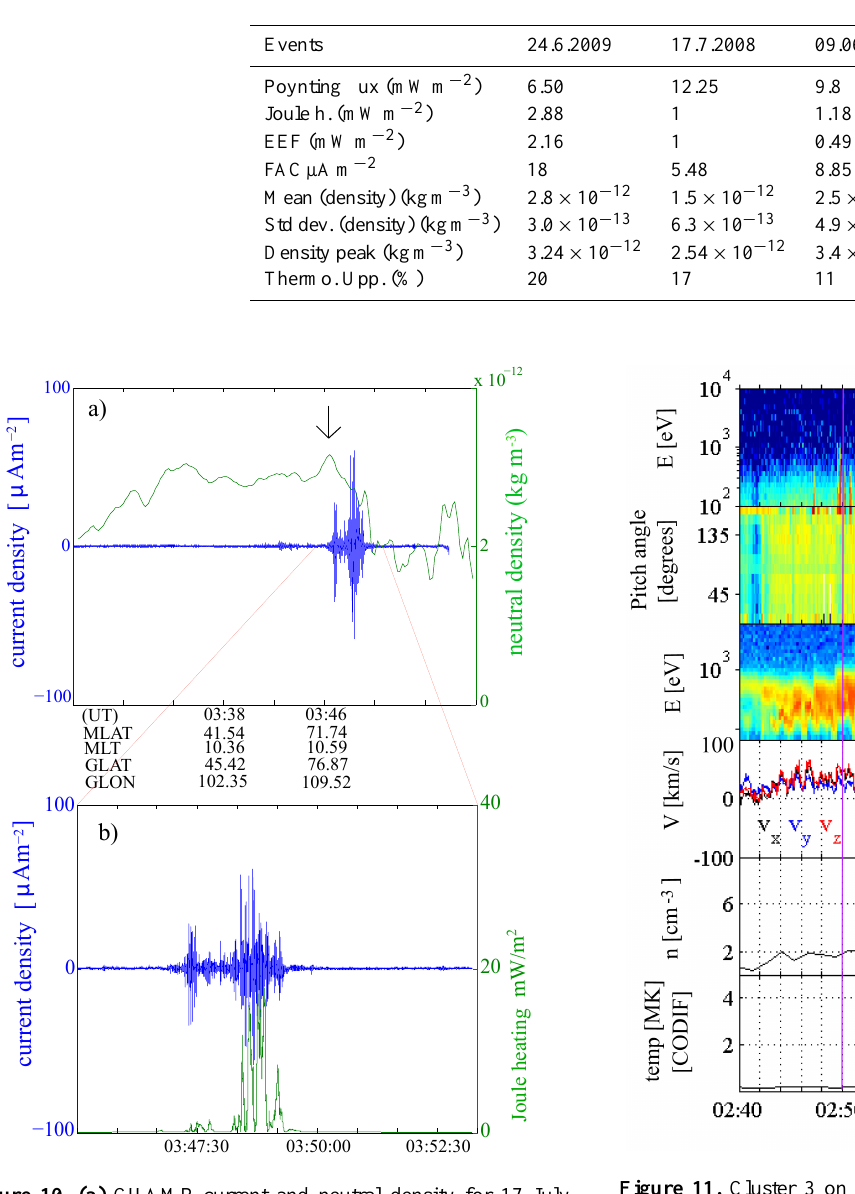
Figure 10. (a) CHAMP current and neutral density for 17 July 2008. (b) Estimated Joule heating for the E layer. On the top of it is the CHAMP FAC density.